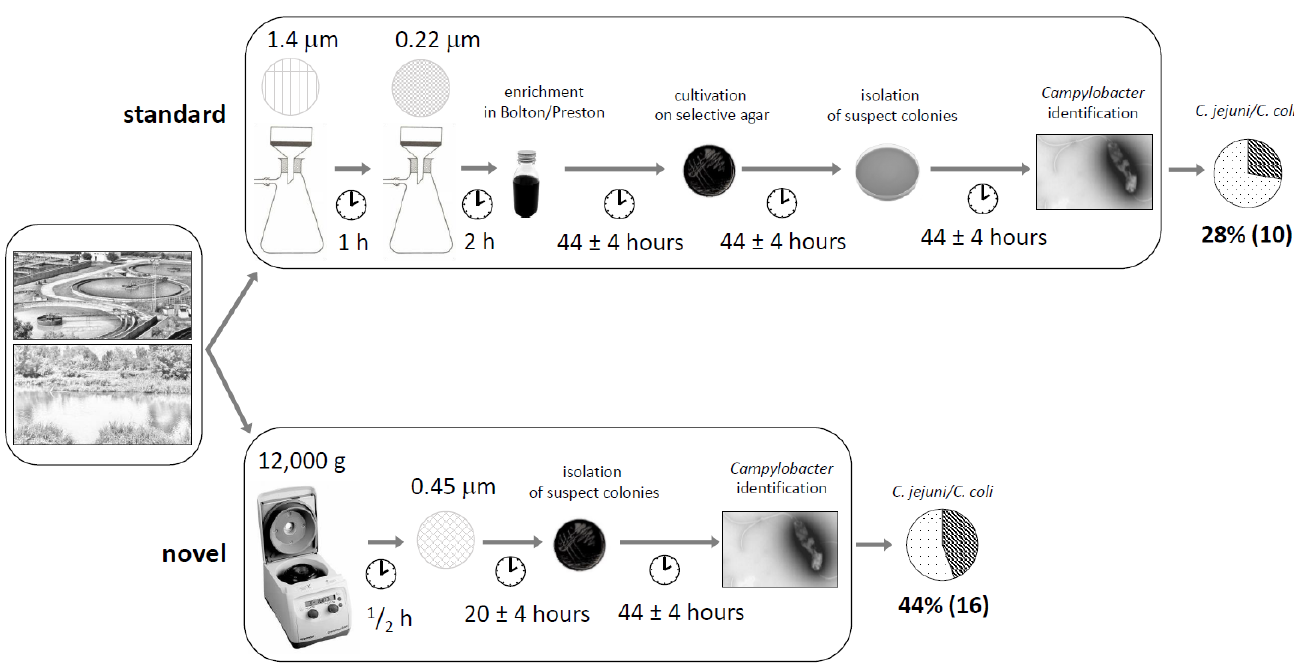
Figure 1. Scheme of standard and novel rapid method for detection of campylobacters, including timing and effectiveness. ISO standard method (above) and novel method (below) were used for isolation and detection of campylobacters from wastewater and surface water samples. Positive samples shown in dark colours.